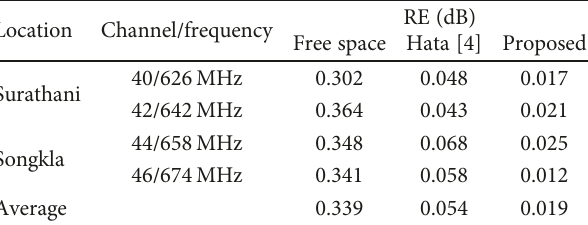
Table 6: RE calculative